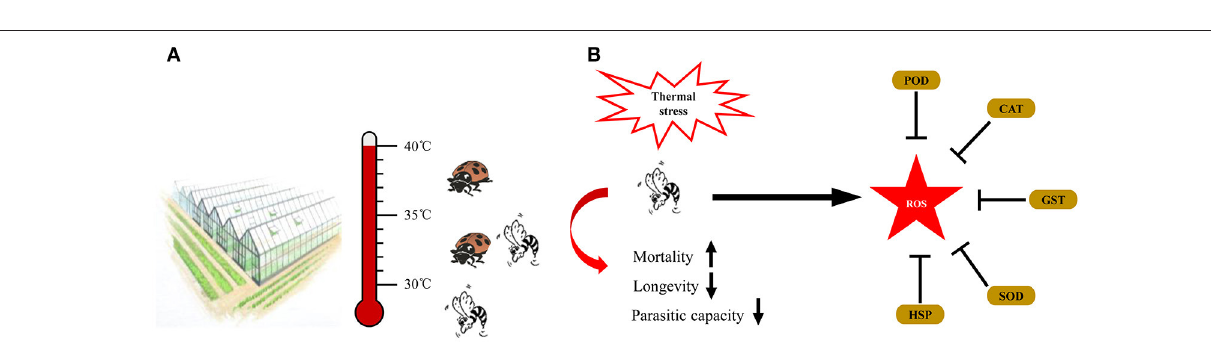
FIGURE 6 | Summary diagram of the integrated application of natural enemies in greenhouse (A) and the coordination of HSPs and antioxidant enzyme genes in Aphidius gifuensis under thermal stress (B)